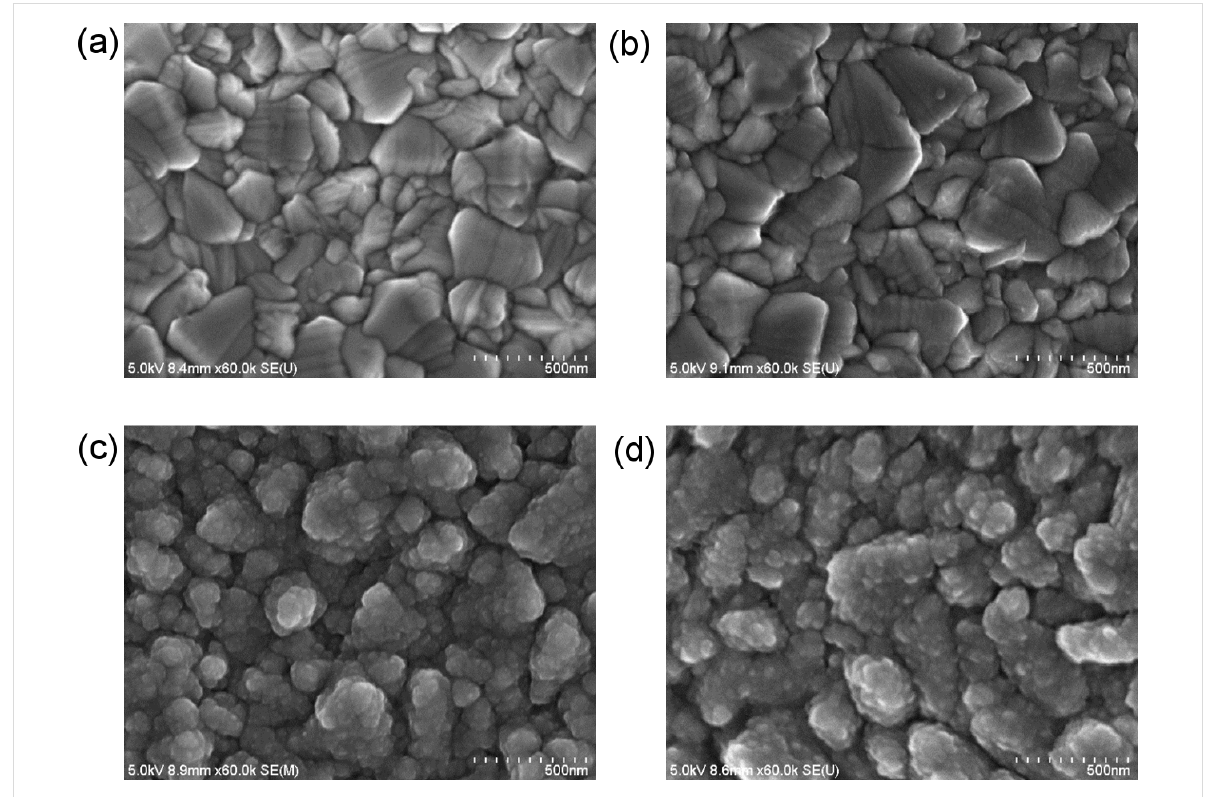
Figure 7: Top view SEM images of a) bare FTO(B), b) FTO(B) covered by 20 SCs of 0.2 M TAA, c) FTO(B) covered by 70 SCs of 0.2 M TAA and d) FTO(B) covered by 70 SCs of 0.2 M TAA with post-calcination at 500 °C.